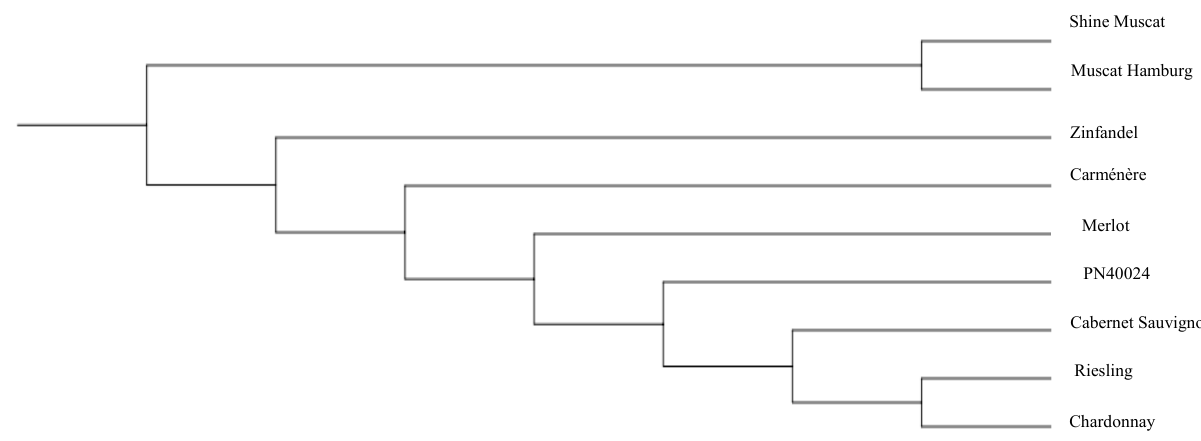
Figure 6. Construction of a grape variety evolutionary tree based on SNPs.